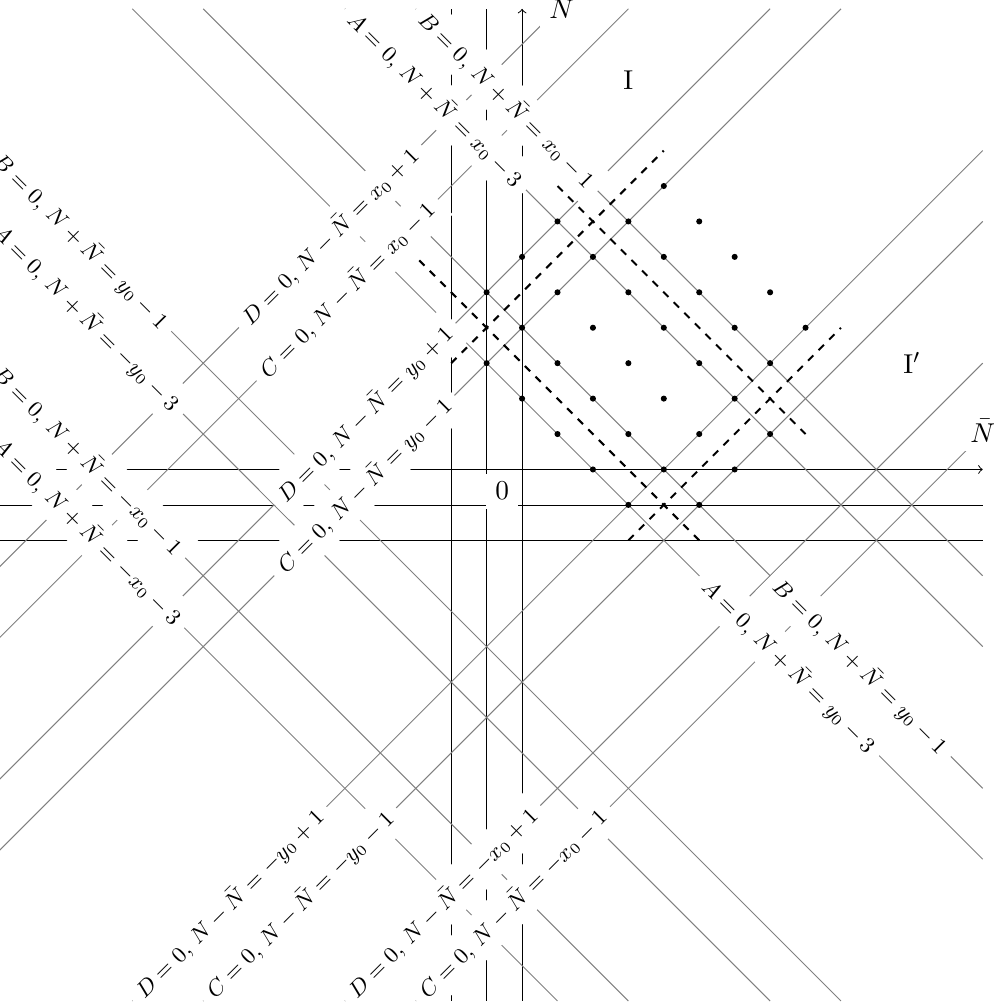
Figure 1 . This figure illustrates the way the decomposition of a parent so (3 , 2) module into submodules may occur. Grey solid lines indicate points of the weight space for which coefficient functions A , B , C and D are equal to zero. Accordingly, the associated components of the deformed translations for these weights vanish. This gives various opportunities for so (3 , 2) modules with a finite number of sl (2 , C ) weights to occur. One such a module is shown above, its weights separated from the remaining weight lattice by two pairs of dashed lines. Two pairs of lines parallel to the coordinate axes indicate locations at which degeneracies of (2.15), (2.16)